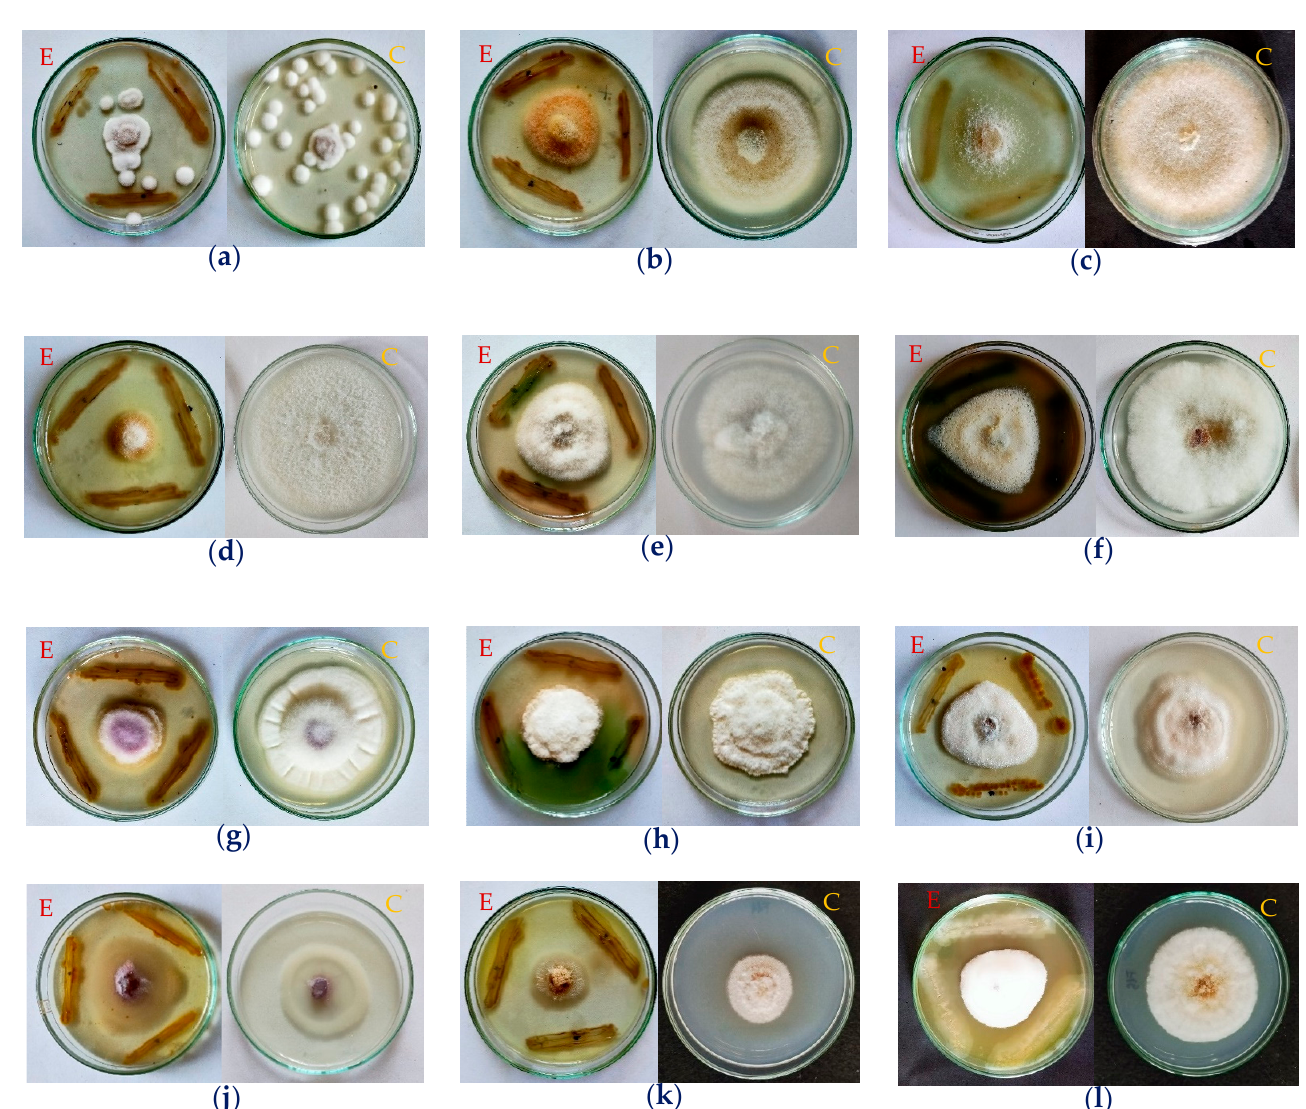
Figure 6. Evaluation of anti-fungal activity of Pseudomonas aeruginosa TUN03 against various plant plant-pathogen strains, including Purpureocillium lilacinum F01 ( a ), Fusarium solani F02 ( b ), F. solani F03 ( c ), F. solani F04 ( d ), C. gloeosporioides F05 ( e ), F. incarnatum F06 ( f ), G. butleri F07 ( g ), Pestalotiopsis mangiferae F08 ( h ), F. incarnatum F09 ( i ), F. oxysporum F10 ( j ), Neonectria sp. F11 ( k ), and F. incarnatum F15 ( l ). A mycelial plug of growing fungal strain was placed into the center of the Petri dish containing PDA (potato D-glucose agar) medium and three lines of Pseudomonas aeruginosa TUN03 was streaked at a distance of 2 cm from the center of the surface of PDA medium in Petri dishes. These plates were then maintained at 28 °C for 5 d. The experimental and control dish are labeled as E and C , respectively.